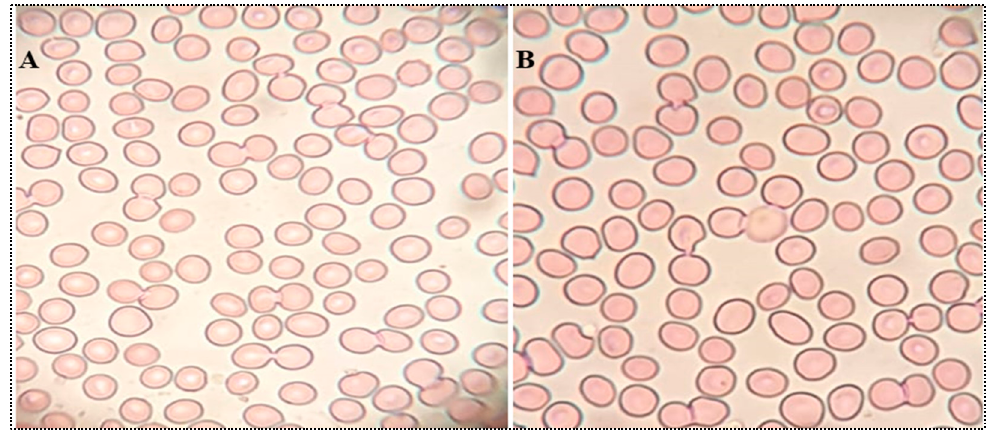
Figure 11. Isotonicity images of ( A ) normal saline and ( B ) moxifloxacin-loaded bilosome in situ gel (MX-BSop-Ig4).